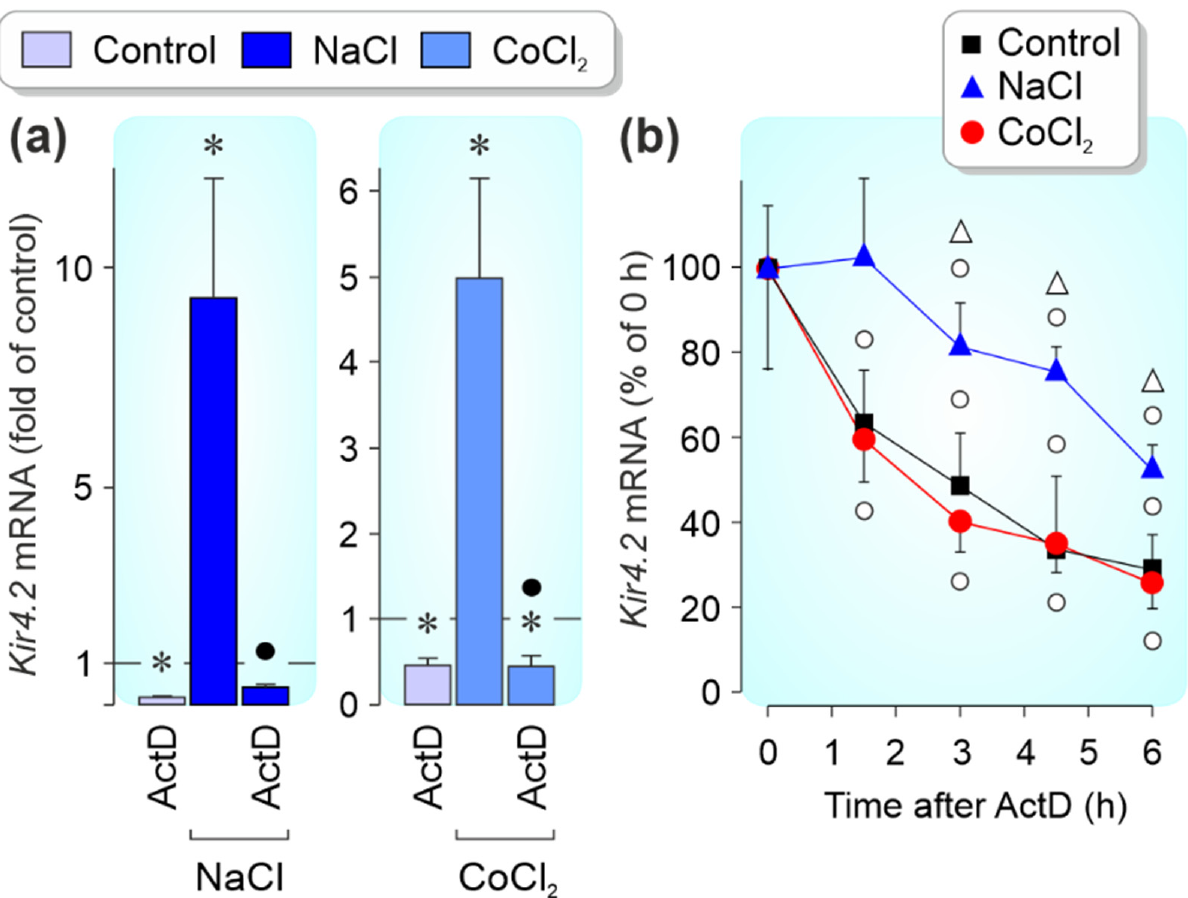
Figure 4. Kir4.2 gene transcription and mRNA stability. The hyperosmotic and CoCl 2 -induced expression of the Kir4.2 gene in cultured RPE cells is mediated by stimulation of gene transcription;